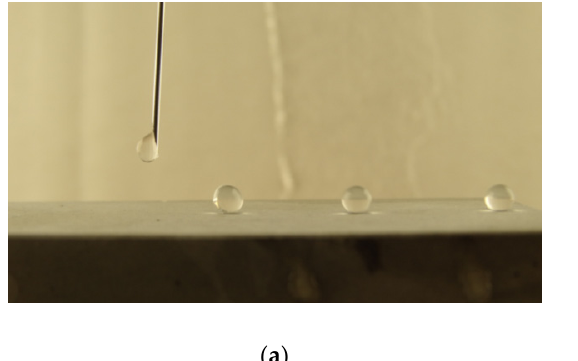
Figure 3. ( a ) Water drops rolling off ( b ) Water contact angle measurement.